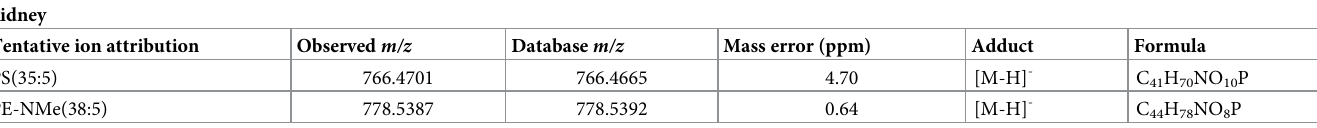
To further investigate low-entropy spots, we changed mass and spatial resolutions for the 31-month mouse kidney. The mass resolution is commonly defined as the ability to separate two narrow mass spectral peaks. As the mass resolution gets lower, adjacent peaks become indistinguishable. At each spot, there were 2500 intensities in the m/z -axis as the interval from Table 1. Tentative assignments of candidate molecules. kidney Tentative ion